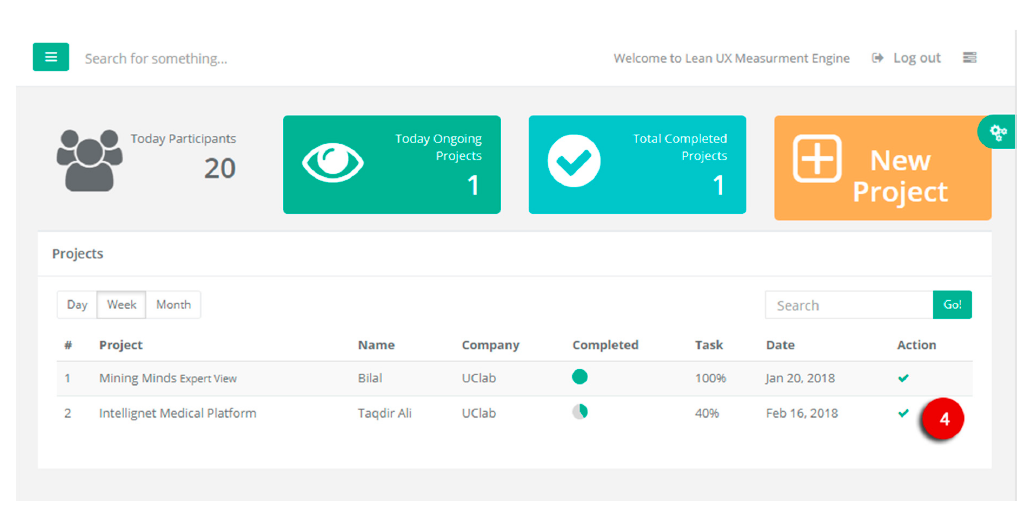
Figure A2 . Dashboard of Lean UX- List of created projects for UX evaluation.